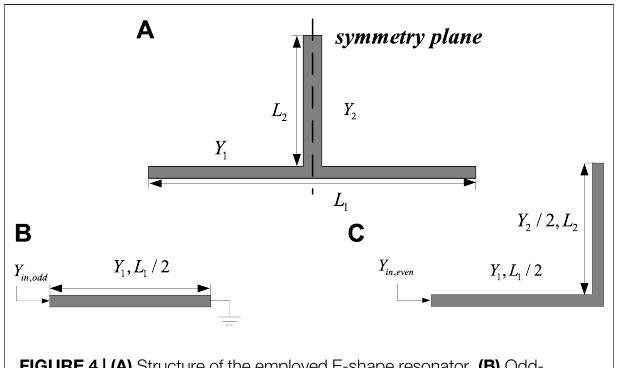
FIGURE 4 | (A) Structure of the employed E-shape resonator. (B) Odd- mode equivalent circuit. (C) Even-mode equivalent circuit. ⎛⎜⎜⎜⎜⎜⎜⎜ ⎜ ⎜ ⎜ ⎜ ⎜ (cid:2) Y ⎝ 2